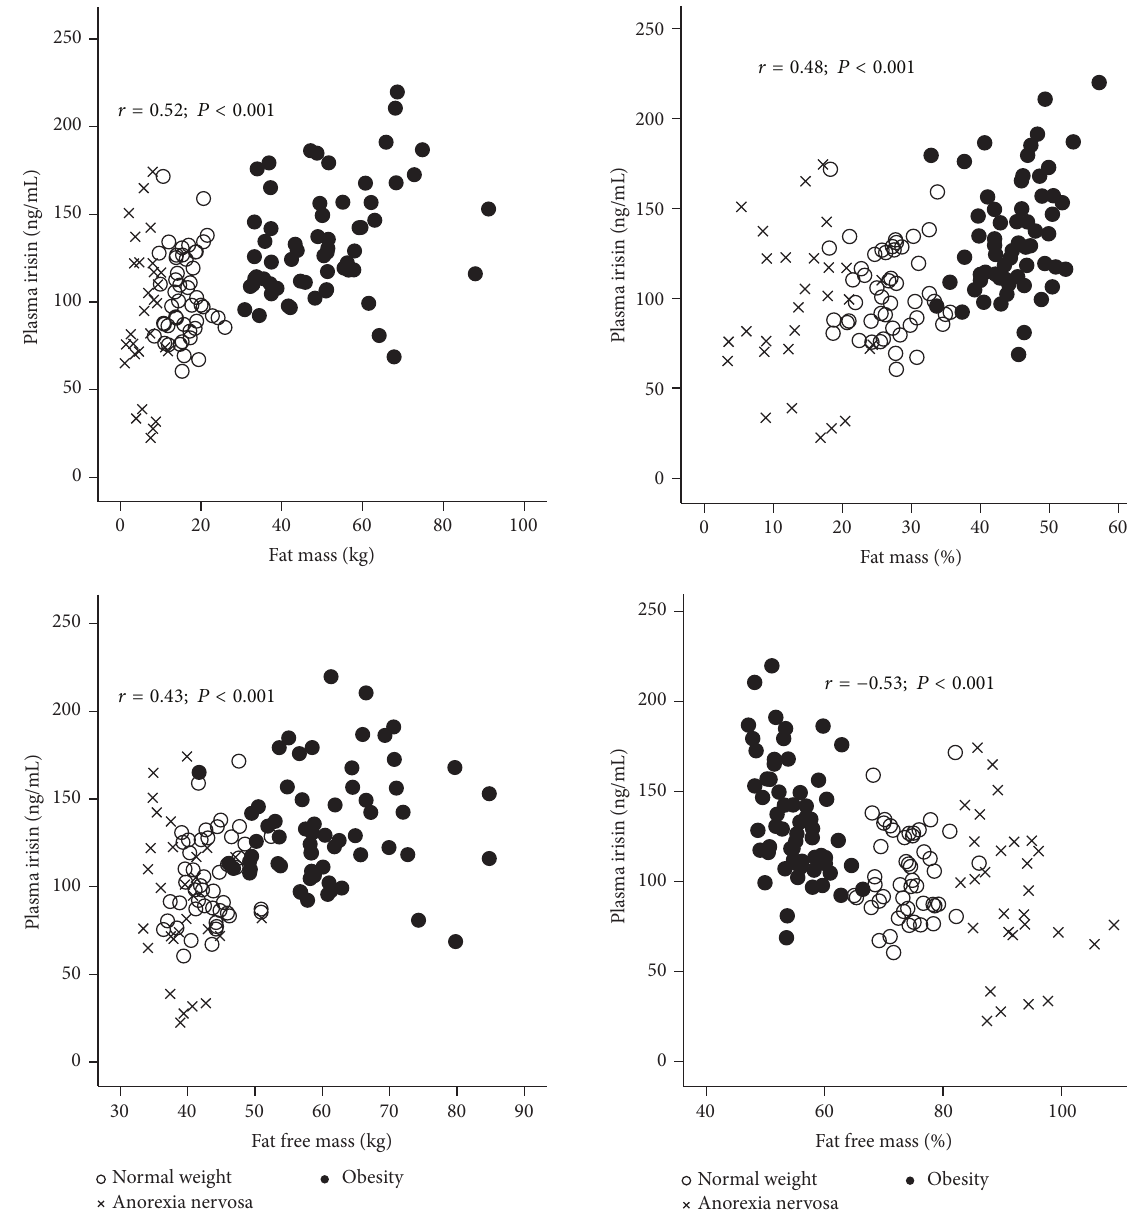
Figure 2: Correlation of circulating irisin with fat mass and fat-free mass. Plasma irisin correlation with fat mass (kg), fat mass (%), fat-free mass (kg), and fat-free mass (%) for the three groups (NW, AN, and OB) is shown.